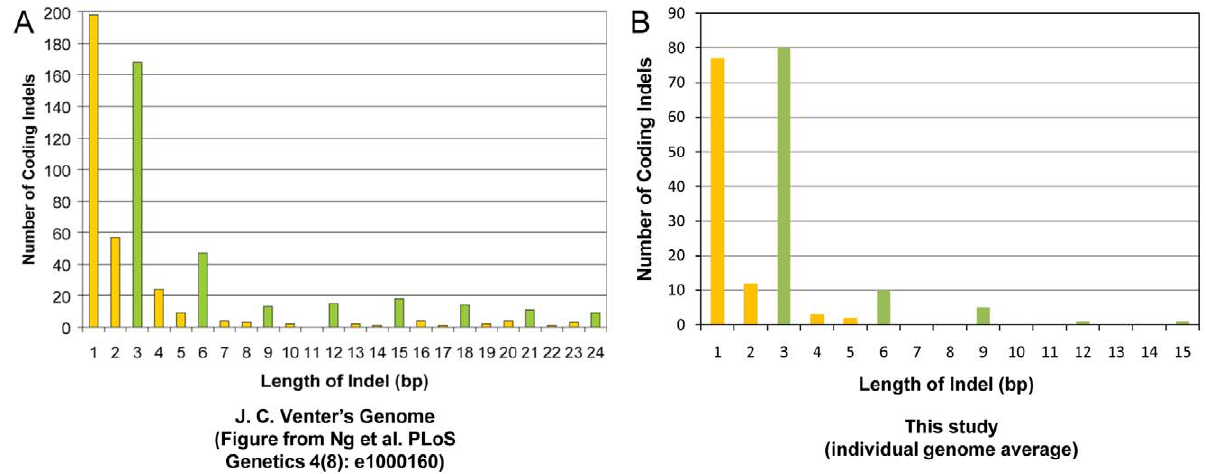
Figure 3. Coding indel length distribution. Shown is a side-by-side comparison of the length of the coding indels in this study as compared to a previous publication [26]. (A) Indel lengths observed in J.C. Venter’s exome [26] versus (B) indel lengths observed in this study. The data from our study have been restricted to the canonical genes or transcripts that are captured by the Agilent SureSelect Targeted Enrichment system. Indels that are a multiple of 3bp in length are marked in green.